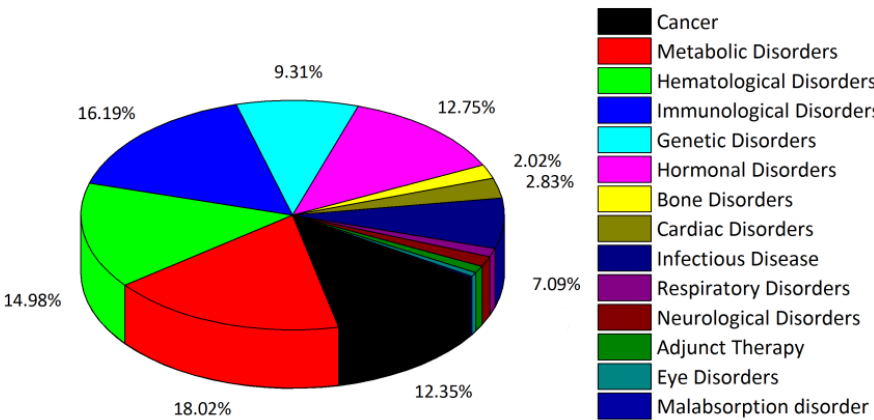
Figure 1. Disease/disorders targeted by therapeutic peptides and proteins according to the summary statistics of the THPdb database of FDA-approved therapeutic peptides and proteins [13,14]. The data were plotted using THPdb statistics page [14] information. Numerical values for under-represented disorders (<2%), such as Respiratory Disorders (~1.21%), Neurological Disorders (~1.42%), Adjunct Therapy (~1.01%), Eye Disorders (~0.61%) and Malabsorption disorder (~0.20%) are omitted on the pie chart for the ease of reading.